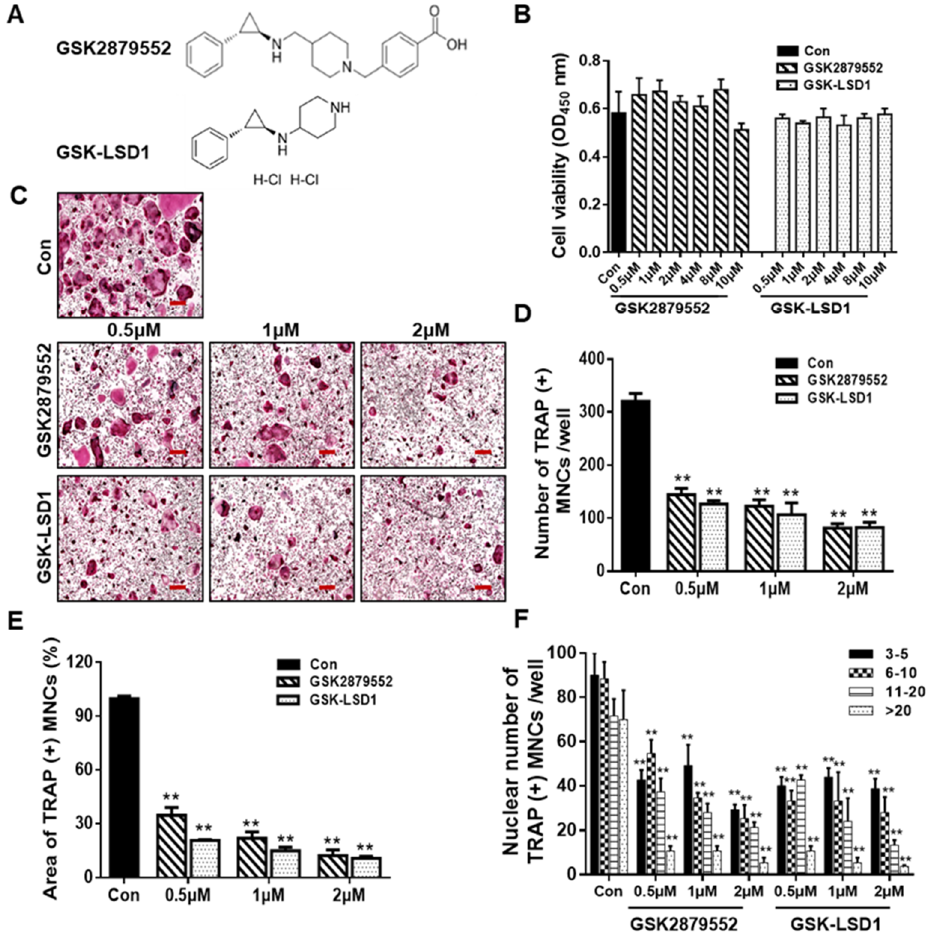
Figure 2. LSD1 inhibitors prevent RANKL-stimulated osteoclast differentiation in a dose-dependent manner. ( A ) Structure of GSK2879552 and GSK-LSD1. ( B ) BMMs were treated with or without LSD1 inhibitors for 48 h. Cell viability was confirmed by the EZ-cytotoxicity kit. OD, optical density. ( C ) BMMs were incubated with M-CSF and RANKL cultured at different dosages of LSD1 inhibitors (0.5, 1, and 2 µM) for 4 days, and stained with the TRAP staining kit. Scale bar = 200 µm. ( D , E ) Average area and number of TRAP (+) MNCs in the three wells using Image J software. ( F ) Nuclei number of TRAP (+) MNCs were analyzed using Image J. Data are presented as mean ± SD of three independent experiments; ** p < 0.01 versus the control group.